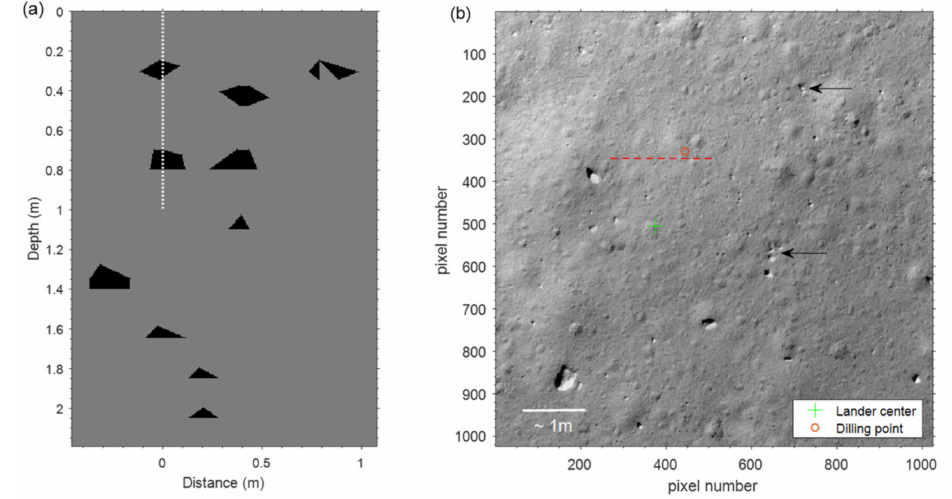
Figure 6. ( a ) Structure diagram of regolith under the CE-5 lander. The black color indicates the approximate extent of rocky regions in the regolith. The dotted line indicates the drilling trajectory of the drill. ( b ) Lunar surface image obtained by LCAM just before the lander touched the Moon. The dashed line represents the projection of antennas #1 to #10 on the lunar surface. Black arrows indicate two examples of aggregate fragments. The positions of lander center and drilling point are determined according to the work from Zheng et al. [1].